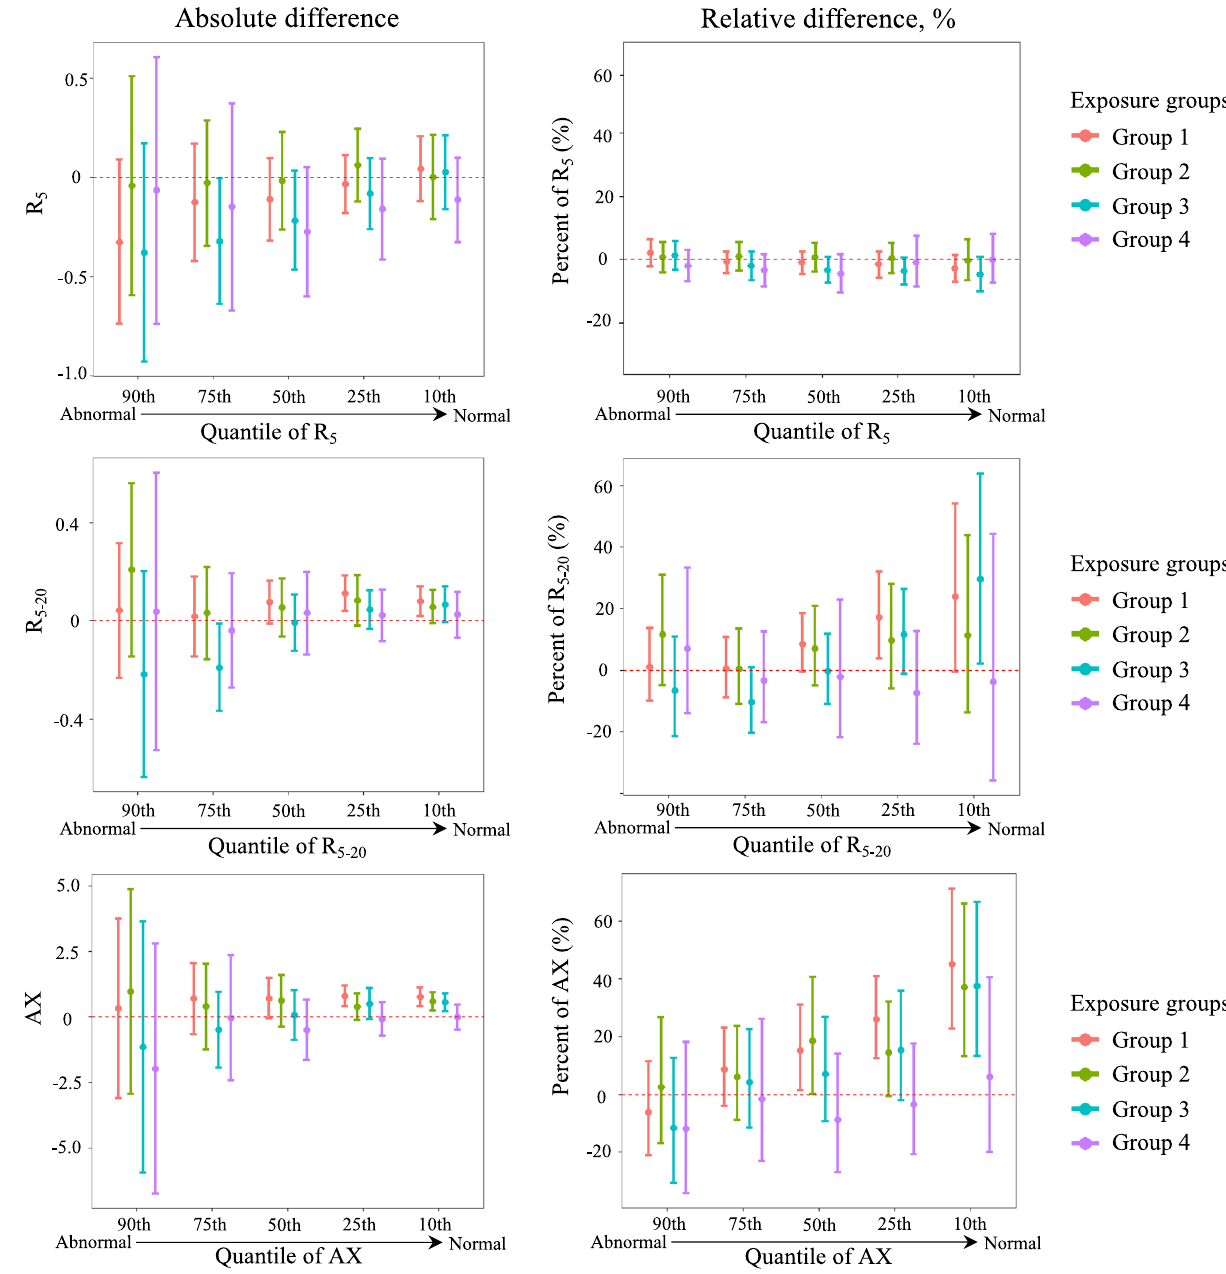
Figure 5. Estimates of absolute and relative effects on quantiles of R 5 , R 5–20 , and AX. X-axis denotes five quantile levels, and y-axis is the estimated absolute or relative difference on R 5 , R 5–20 , and AX. The colors represent four latent Group 1–4 vs. Group 5 (reference). The horizontal red dash line represents zero null effect. R 5 : pre-bronchodilator total airway resistance to 5 Hz. R 5–20 : pre-bronchodilator frequency dependence of resistance as difference between resistance at 5 Hz and 20 Hz. AX: pre-bronchodilator reactance curve area below